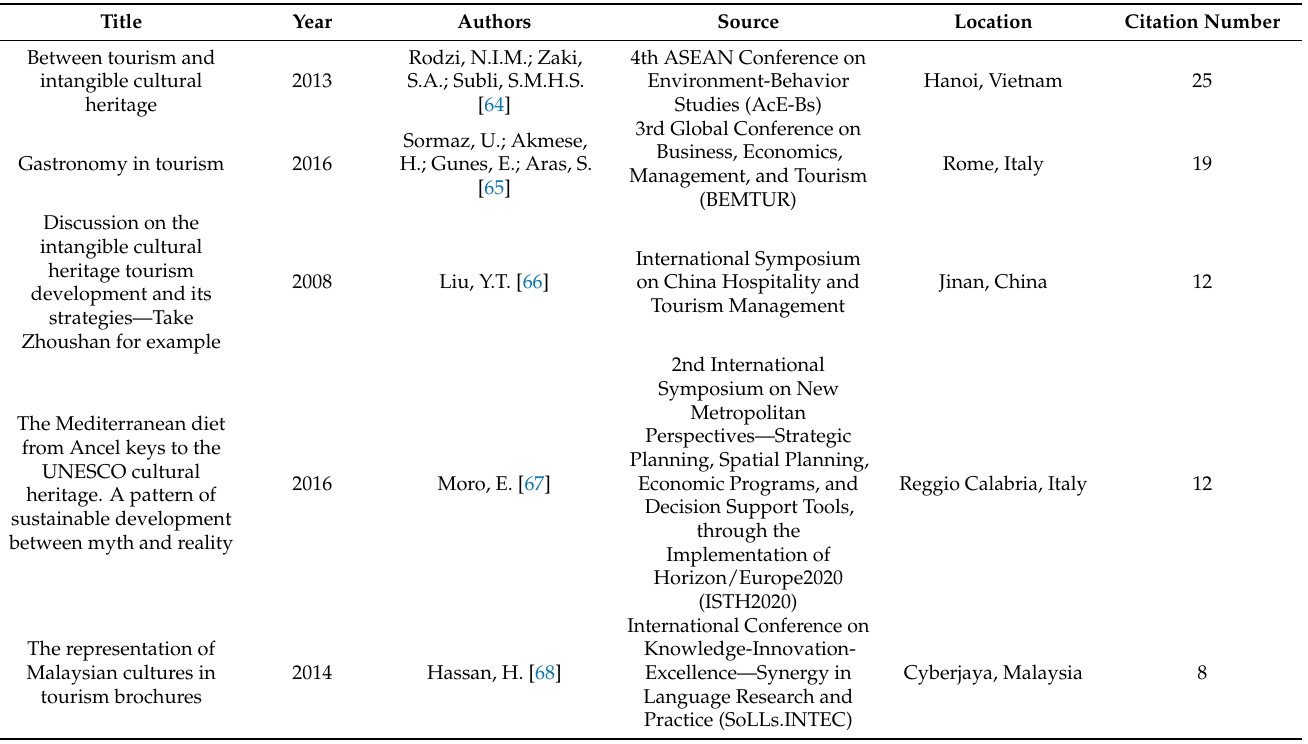
Table 4. Top 10 conference proceeding papers on WOS ordered by citation